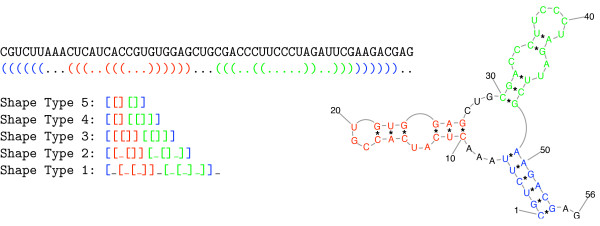
An example secondary structure and its five shape representations.